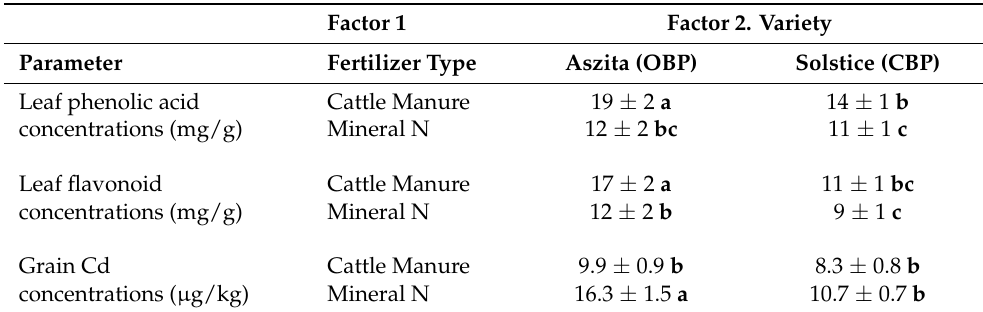
Table 9. Interaction means ± SE for the effects of fertilizer type and variety on leaf phenolic acid and flavonoid and grain Cd concentrations in two winter wheat ( T. aestivum ) field trials carried out at Nafferton Farm, Northumberland,